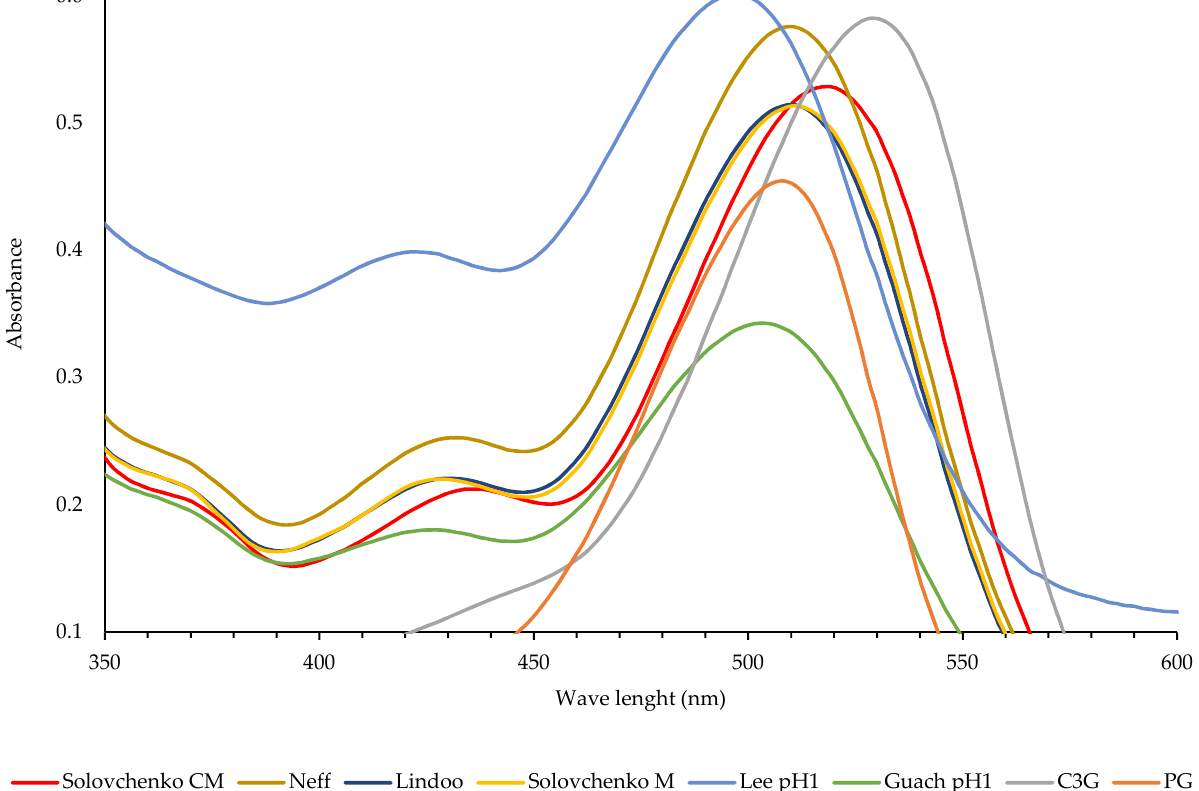
Figure 1. The absorption spectrum of fresh strawberry anthocyanins extracted from six different methods. The methods were: (1) methanol (M) method by Solovchenko et al. [5], (2) chloroform- methanol (CM) method by Solovchenko et al. [5], (3) methanol method by Lindoo and Caldwell [6], (4) chloroform-methanol method by Neff & Chory [7], (5) pH differential method (pH 1.0) by Lee et al. [10], and (6) combination of methanol and pH differential methods (step 2, pH 1.0) by Gauche et al. [11]. Cyanidin-3-O-glucoside (C3G) and pelargonin (PG) were used as the internal standards.